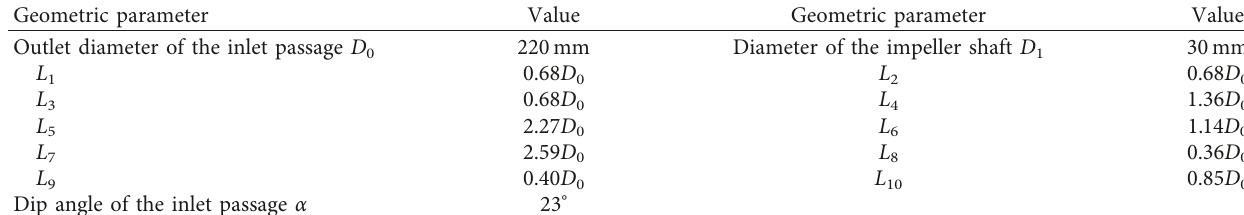
Table 1: Basic geometrical parameters of the inlet passage.